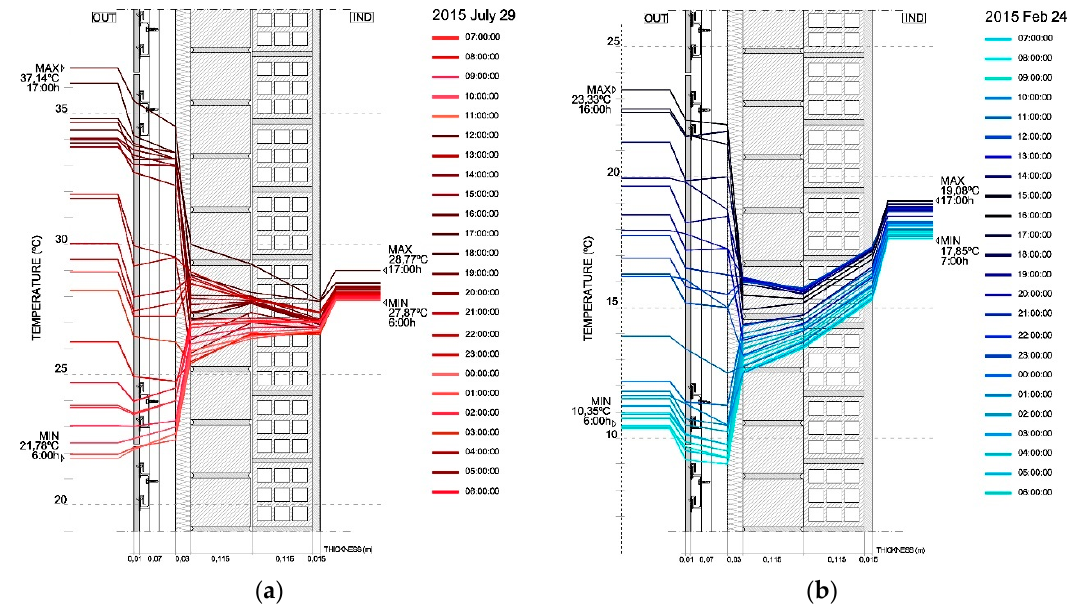
Figure 15. The temperate gradients for each hour. ( a ) 29 July 2015; ( b ) 24 February 2013.